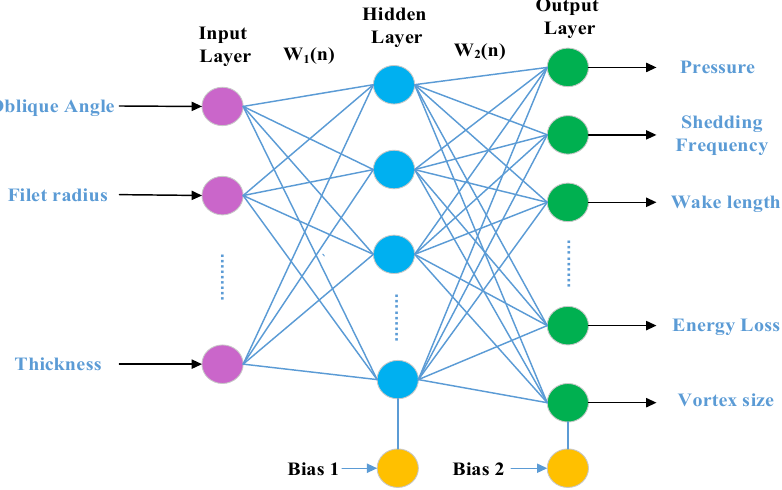
Figure 5. Scheme of artificial neural networks.